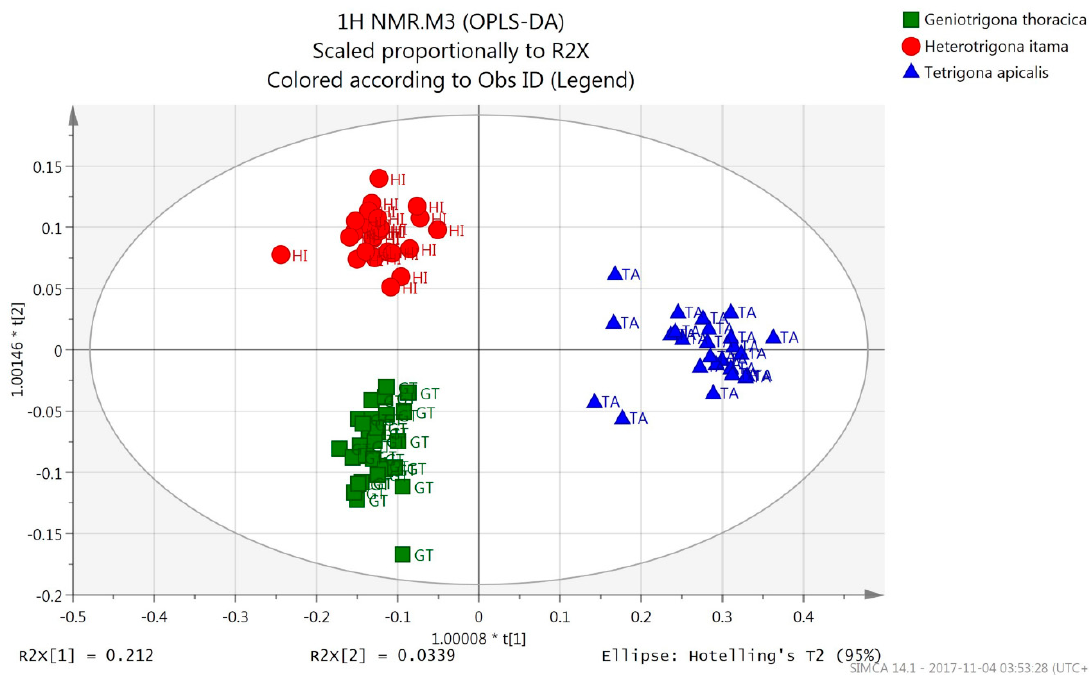
Figure 1. The OPLS-DA score scatter plot of 1 H-NMR spectral data. Table 1. The misclassification table for OPLS-DA model of three types of stingless bee honey.